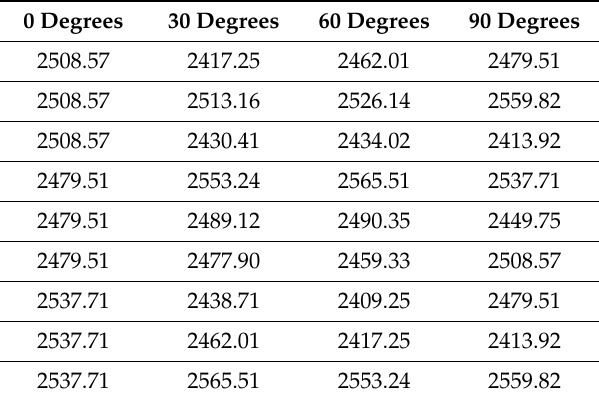
Table 8. DOE for the impact of angular orientations on E.